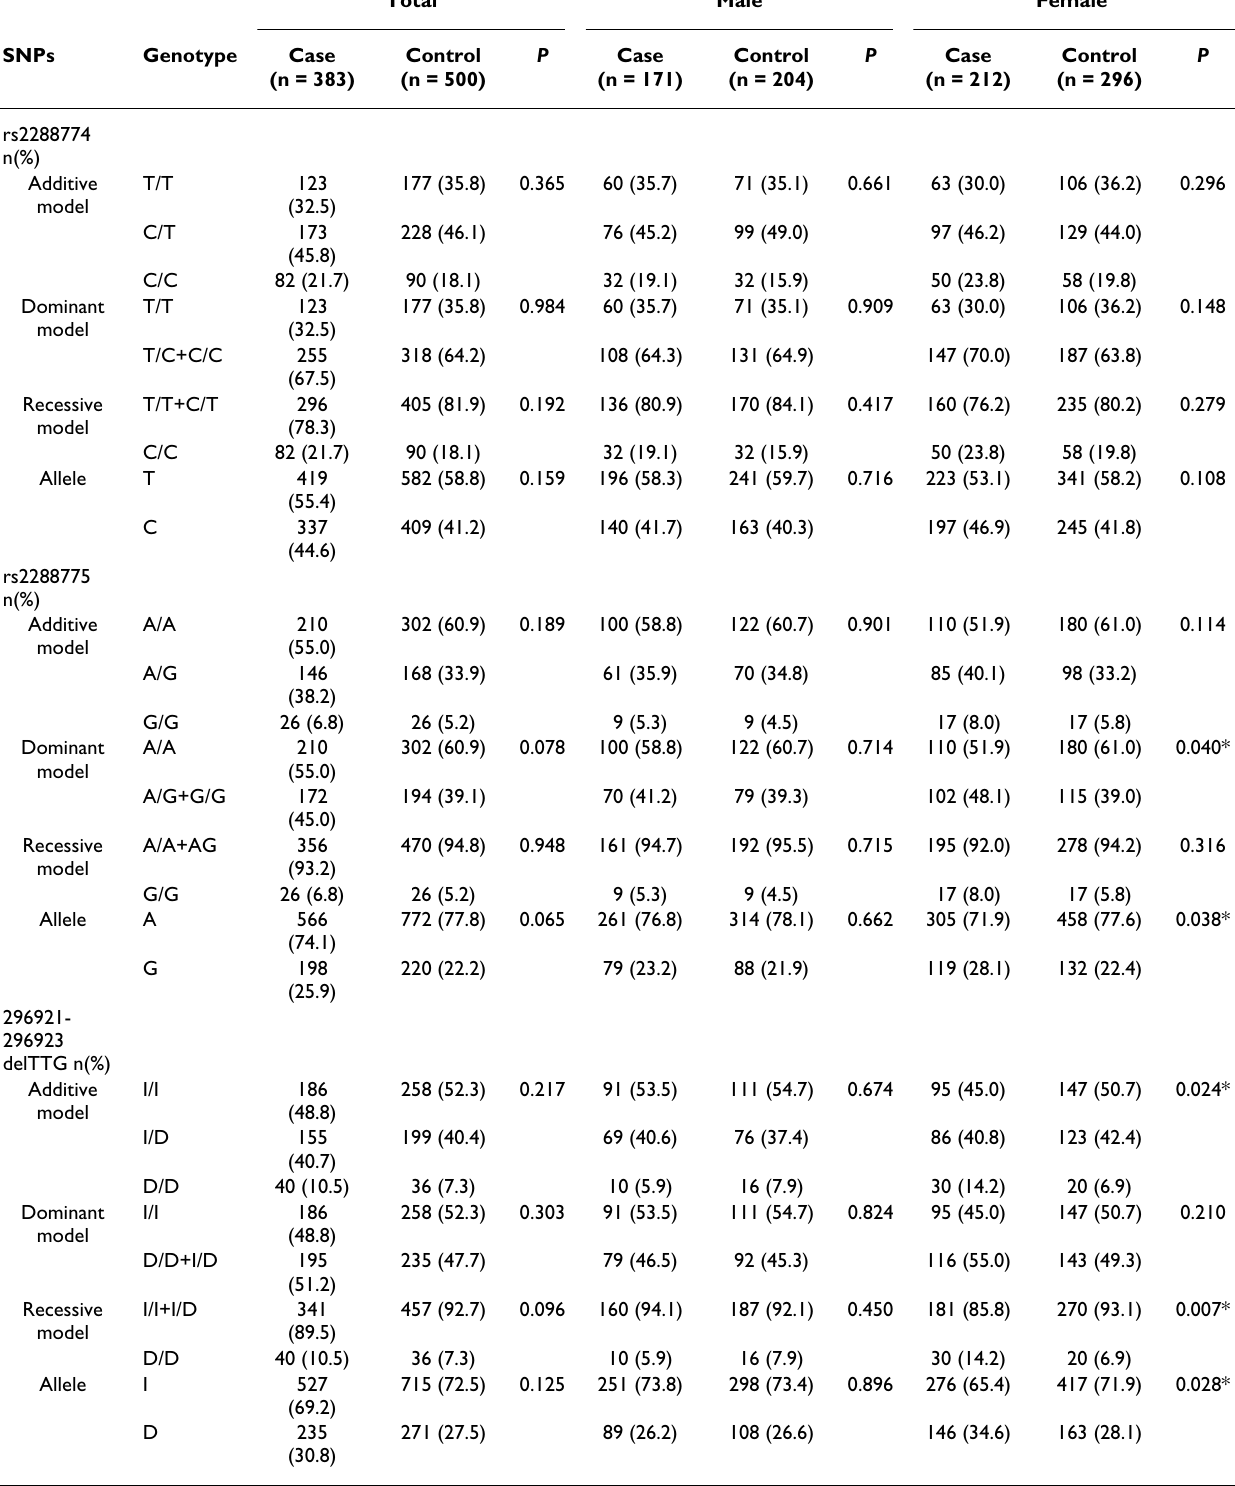
Table 3: Genotype and allele distributions in patients with essential hypertension and in control individuals Total Male